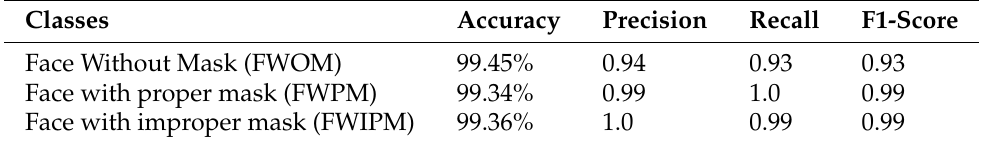
Table 8. Statistics using CNN by